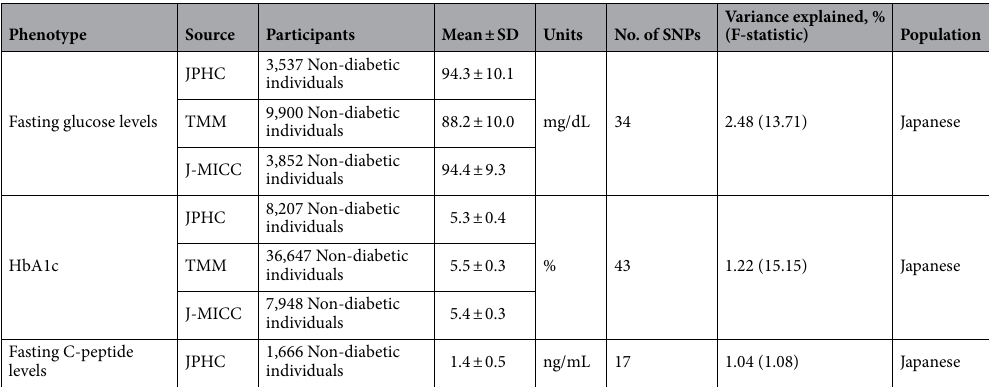
Table 1. Characteristics of the studies considered for the analysis of single nucleotide polymorphism- exposure associations in the Japanese Consortium of Genetic Epidemiology Studies. HbA1c haemoglobin A1c, HERPACC the Hospital-based Epidemiologic Research Program at Aichi Cancer Center, J-MICC the Japan Multi-Institutional Collaborative Cohort, JPHC Japan Public Health Center, TMM the Tohoku Medical